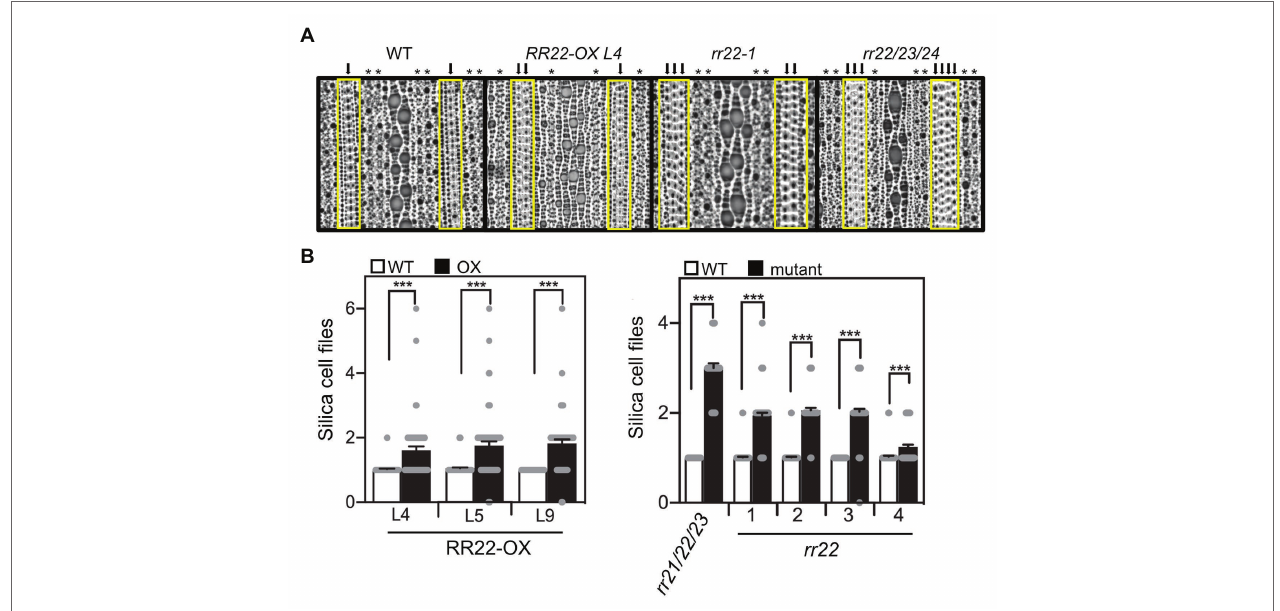
FIGURE 4 | Leaf cell file phenotypes of RR22-OX , rr22 , and rr21/22/23 mutant lines. (A) Representative images of the abaxial epidermis of the flag leaf. The region containing the silica/cork cell files is highlighted with a yellow box, and each silica/cork cell file indicated with a black arrow. Each stomata file is indicated with an asterisk (*). (B) Quantification for the number of rows of adjacent silica/cork cell files. Impressions from five plants (two per plant) were examined and the number of rows of adjacent silica/cork cell files determined ( n > 47). Error bars show SE. The T -test was used for statistical comparison of each mutant line to its WT sibling (*** p <